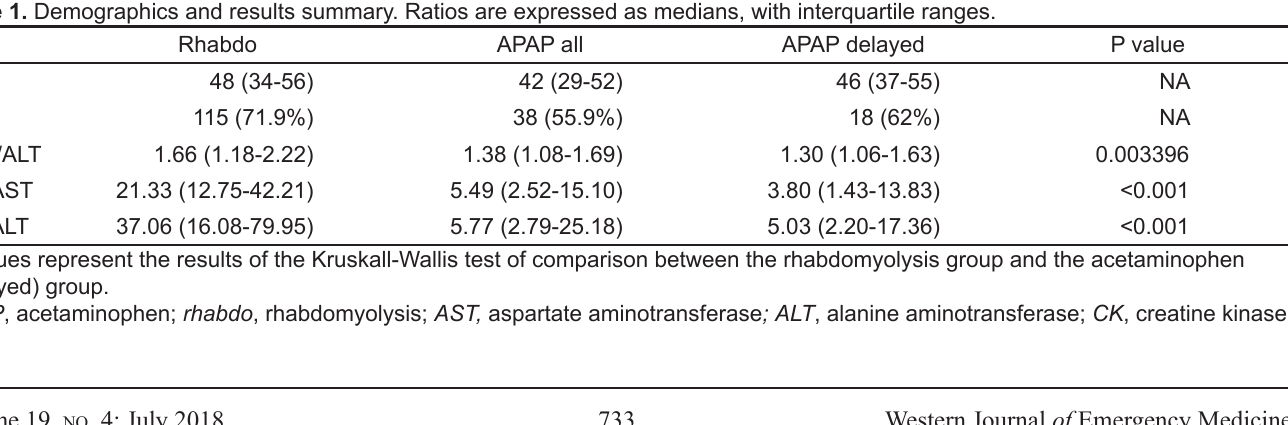
Table 1. Demographics and results summary. Ratios are expressed as medians, with interquartile ranges.